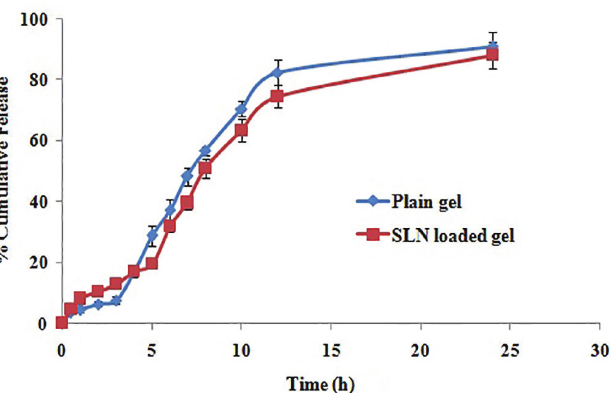
FIGURE 3 - In vitro release profile of developed Plain and SLN loaded